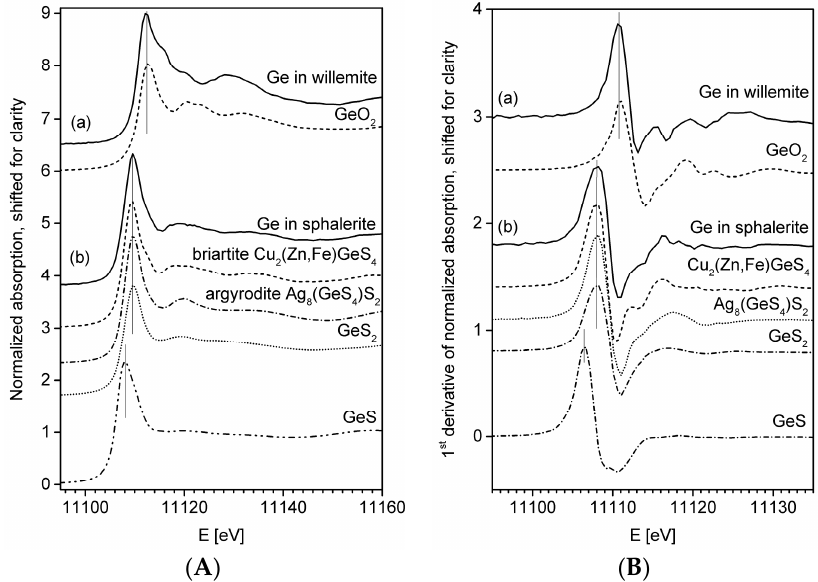
Figure 8. ( A ) Ge K XANES spectra of Ge in ( a ) willemite ( solid line ) compared to GeO 2 ( dashed line ) indicating Ge as Ge 4+ in the oxidic environment of willemite, and ( b ) sphalerite ( solid line ) compared to briartite [Cu 2 (Fe,Zn)GeS 4 ] ( dashed line ), argyrodite [Ag 8 (GeS 4 )S 2 ] ( dash-dotted line ), GeS 2 ( dotted line ) and GeS ( dash double dotted line ). The shift of the white line from Ge monosulfide to disulfides and oxides is indicated by vertical markers at about 1108.0, 1109.6, and 1112.3 eV, respectively. Energy has been calibrated at the Pt L3 edge to 11564 eV. Sample spectra were measured in fluorescence mode, reference spectra in transmission. ( B ) 1st derivative of Ge K XANES spectra of Ge in ( a ) willemite ( solid line ) compared to GeO 2 ( dashed line ) indicating Ge as Ge 4+ in the oxidic environment of willemite, and ( b ) sphalerite ( solid line ) compared to briartite [Cu 2 (Fe,Zn)GeS 4 ] ( dashed line ), argyrodite [Ag 8 (GeS 4 )S 2 ] ( dash-dotted line ), GeS 2 ( dotted line ) and GeS ( dash double dotted line ). The shift of the maxima of the first derivatives from Ge monosulfide to disulfides and oxides is indicated by vertical markers at about 1106.5, 1108.0, and 1110.7 eV, respectively. Energy has been calibrated at the Pt L3 edge to 11564 eV.